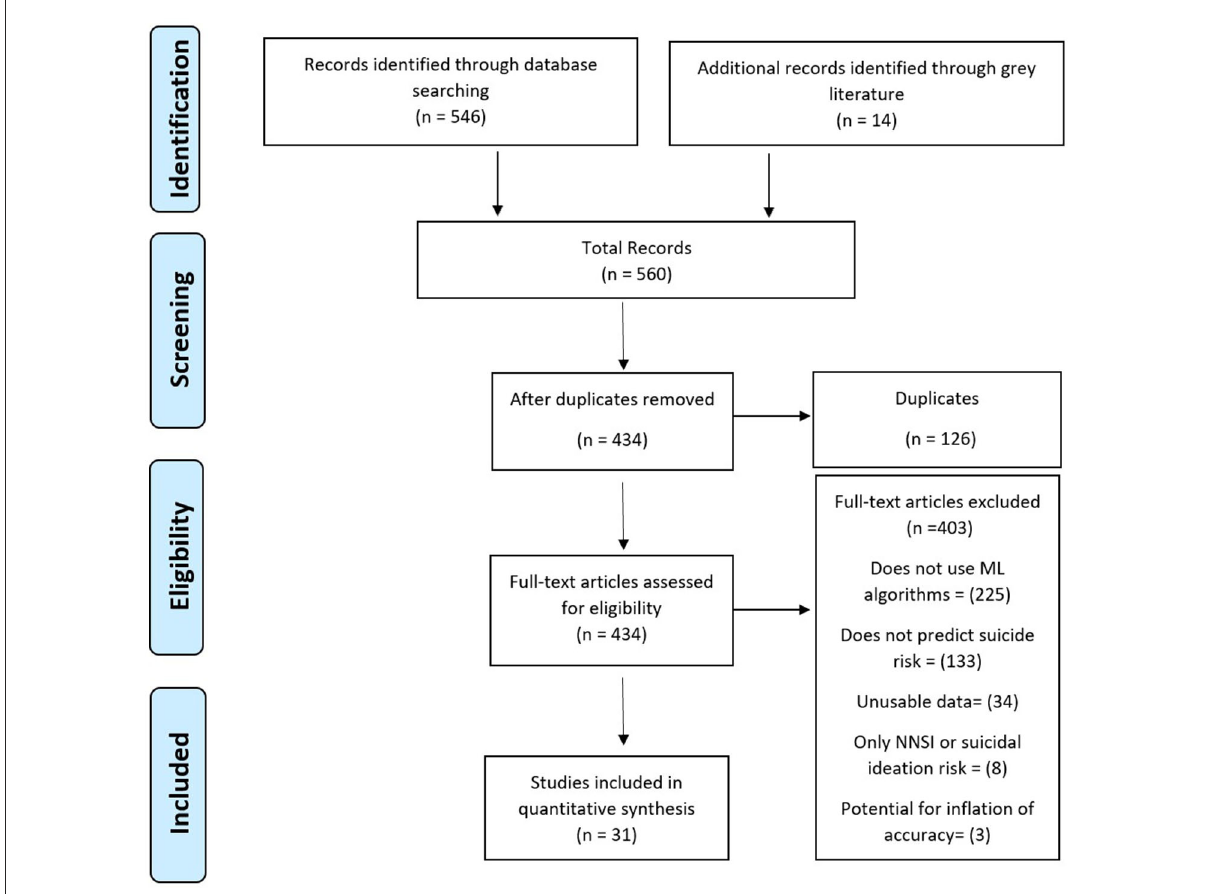
FIGURE1 PRISMA diagram of literature